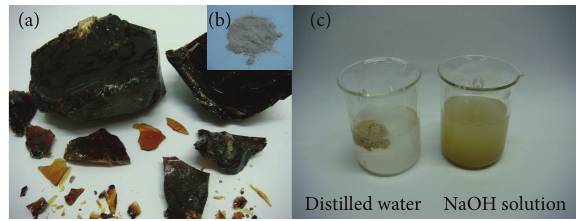
Figure 2: Comparison between the residues before (a) and after (b) grinding and the dispersion in distilled water and NaOH solution